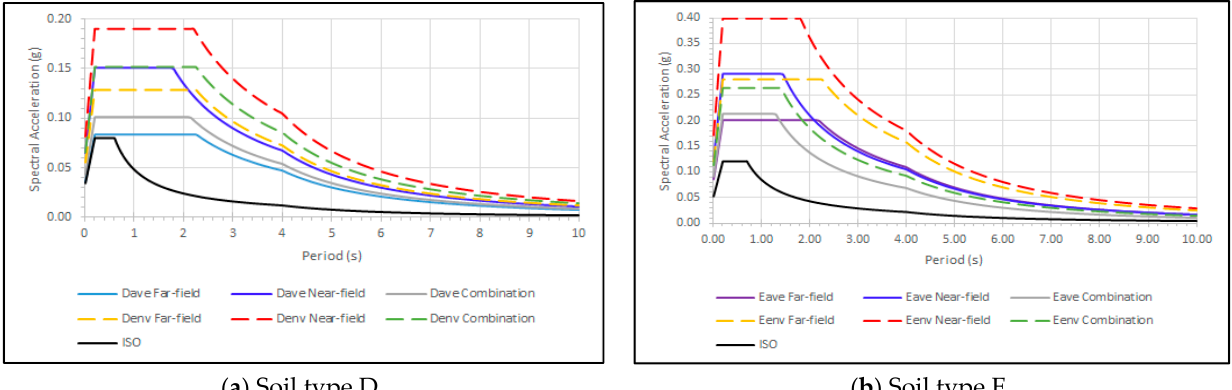
Figure 13. Average spectral acceleration for soil type D.